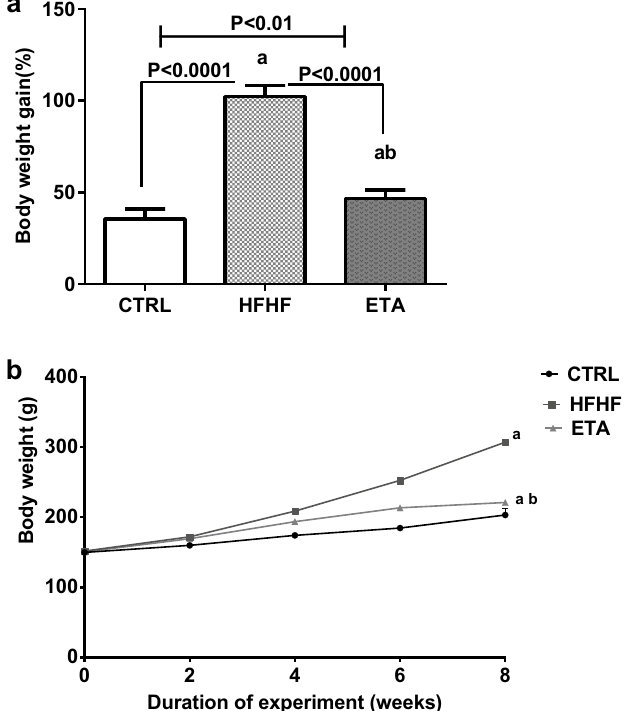
Figure 1. ETA counteracts HFHF-induced body weight gain. Comparison data from the HFHF-fed rats and standard chow-fed rats (CTRL) are shown: ( a ) percent body weight gain and ( b ) gradual increase in body weight. Data are presented as the mean ± SD values and are representative of a single independent experiment ( n = 6). Statistical analysis was performed using one-way ANOVA, followed by Tukey’s multiple comparison tests. a Significantly different from the normal control group. Differences were considered significant if the p-value was < 0.05. CTRL control, ETA etanercept, HFHF high-fat high-fructose